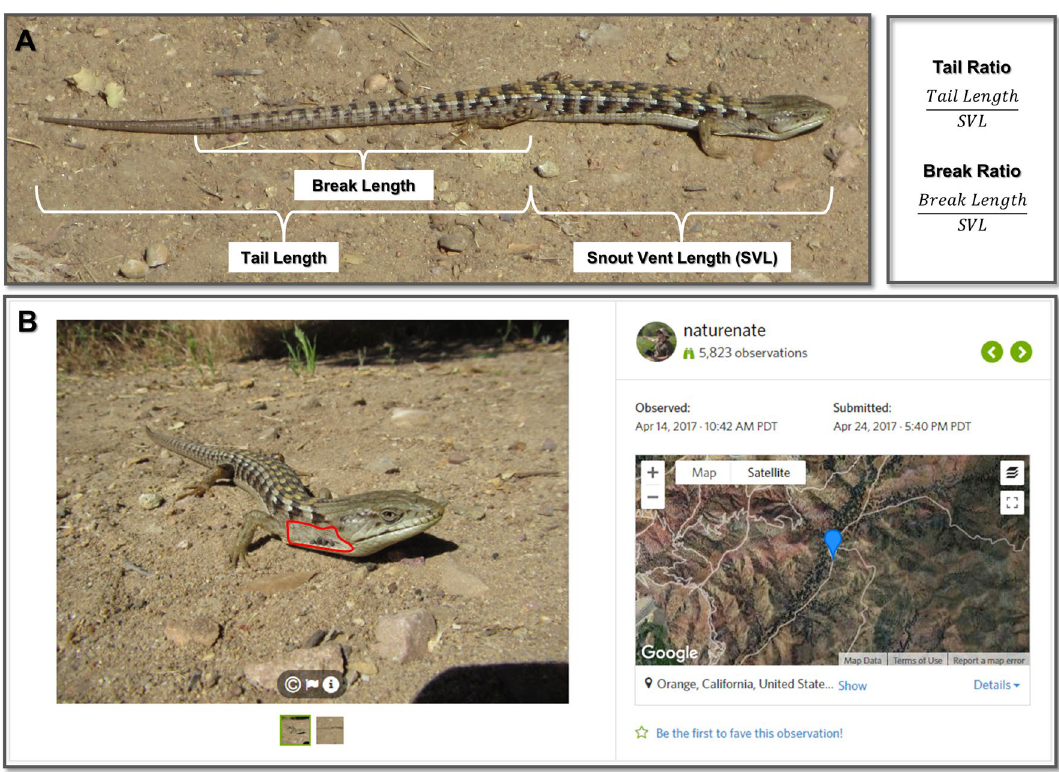
Figure 1. An observation of a Southern Alligator Lizard submitted to iNaturalist with two photographs, both of which were analyzed, showing the traits quantified in this study. ( A ) Body and tail measurements quantified to estimate predation risk. ( B ) The ear region (outlined in red) from which we estimated tick parasitism (with ticks present). The righthand side of the observation shows other data that were extracted including the date and time of observation, the date and time of submission, and the geographic locality. Photo and observation by Nathan Smith (iNaturalist user naturenate; iNaturalist 5945401; https ://www.inatu ralis t.org/obser vatio ns/59454 01). Map data: 2021 Google, 2021 INEGI Imagery and 2021